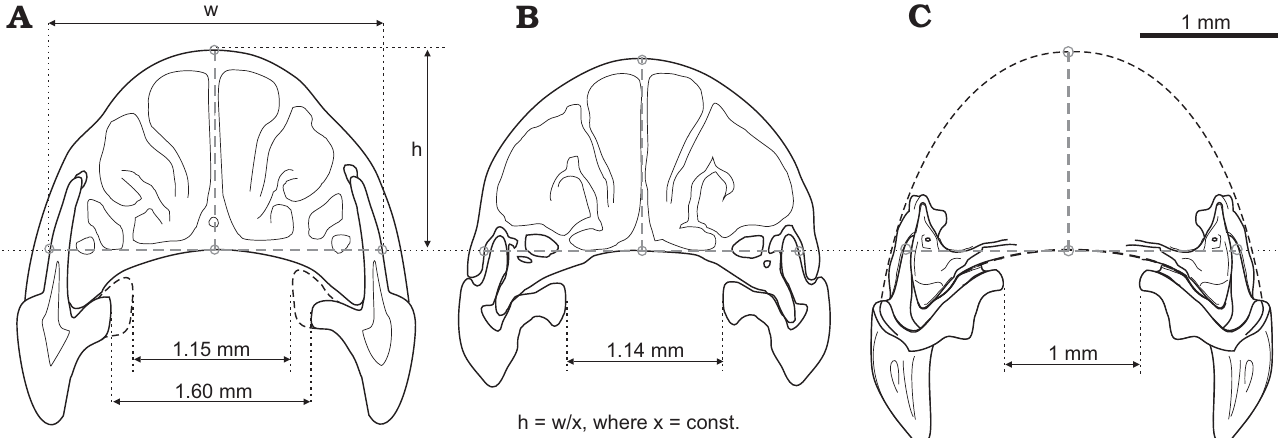
Fig. 9. Drawings of transverse section at the level of P4 antero-buccal root of two Recent crocidurine species (A, B), and reconstruction of the rostrum shape of Shargainosorex angustirostris gen. et sp. nov. (C). A . Crocidura suaveolens (Pallas, 1811) (ZISP 83089). B . Sylvisorex johnstoni (Dobson, 1887) (MNHN 1991-96). C . Combined drawings of the maxilla fragment. Correlation between h (height of rostrum) and w (width of rostrum between lateral sides of antero-buccal root of P4, via top point of the palatine arch) is approximately stable (at least for small-sized crocidurine shrews), and can be ex- pressed by the formula h = w/x, where x =